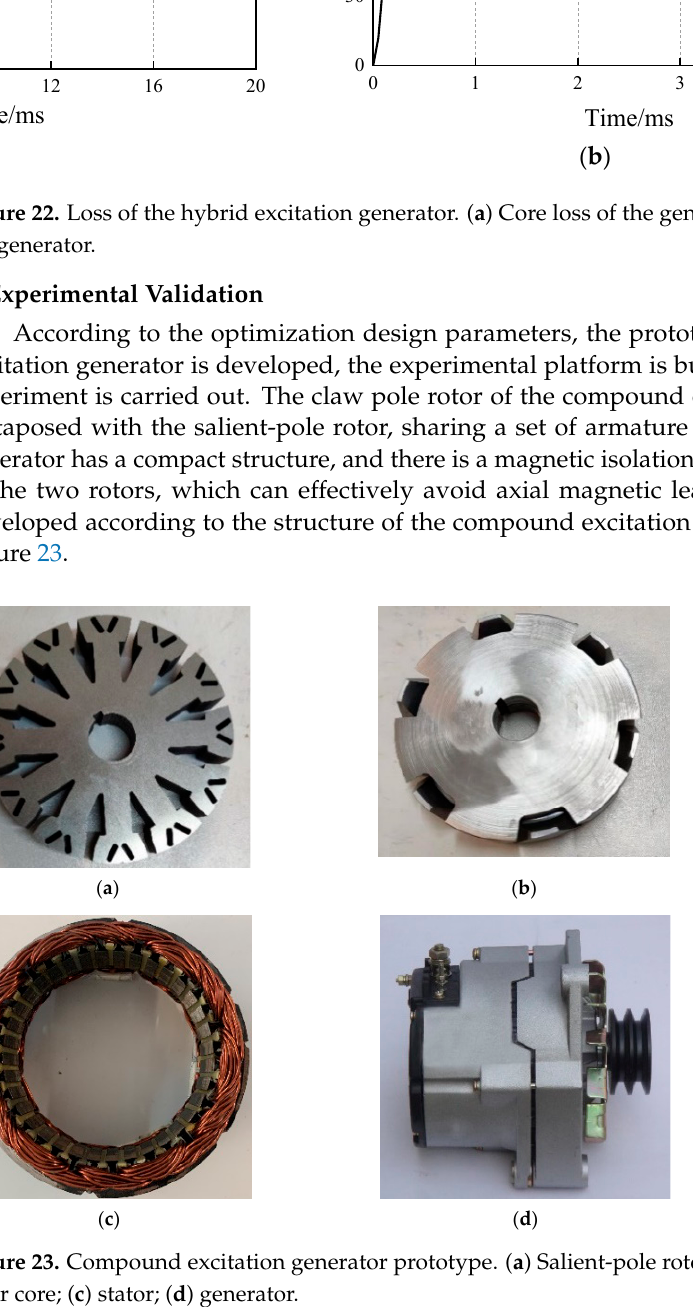
Figure 24. Compound excitation generator prototype experimental platform. 4.1. Generator Output Characteristics The generator prototype is externally connected with pure resistive load and the generator is set to run at 4000 r/min with the excitation current 2 A. The induced EMF of the generator when measuring the size of different load resistances is shown in Figure 25.